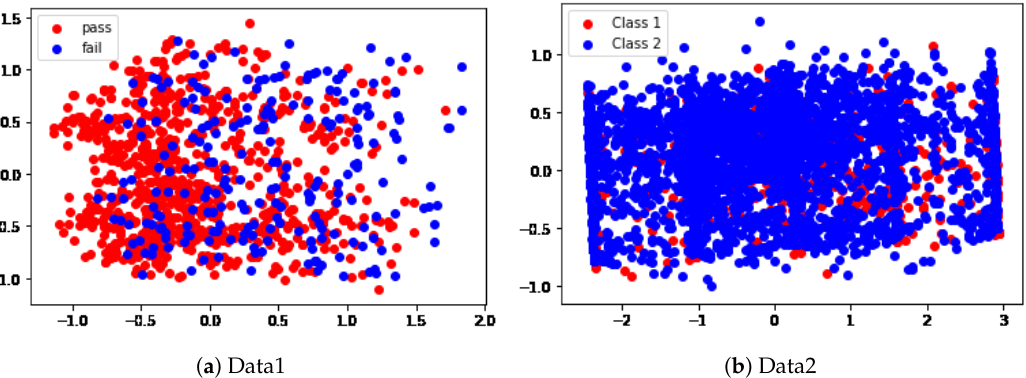
Figure 12. Visualization of distribution of the target class based on the first two principal components of the features in the